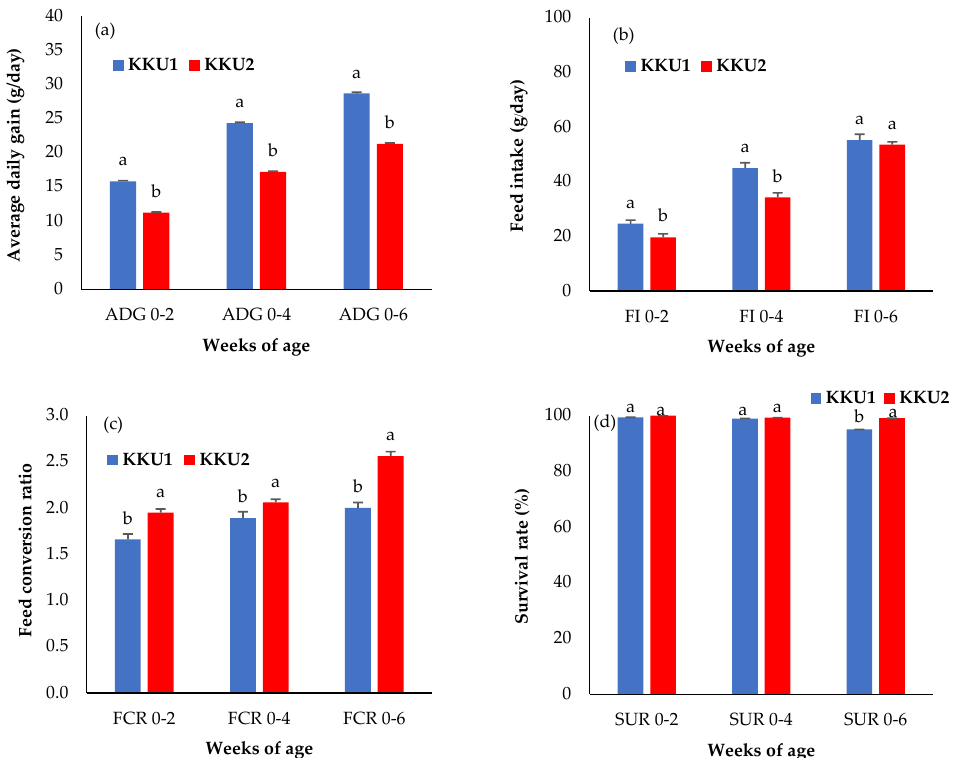
Figure 2. Least square means ± standard error of ( a ) the average daily gain (ADG0–2, ADG0–4, and